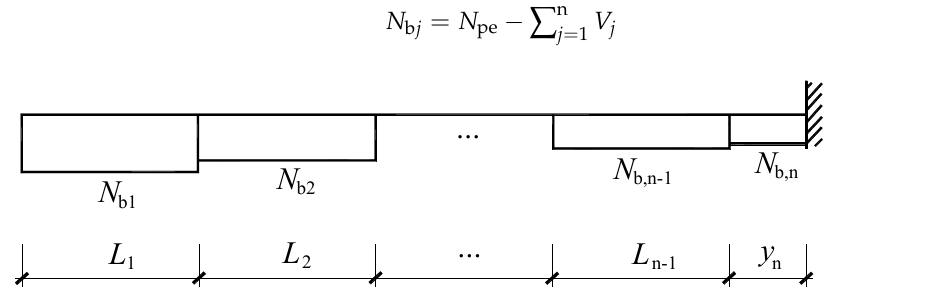
Figure 3. Axial force of beam under preload.